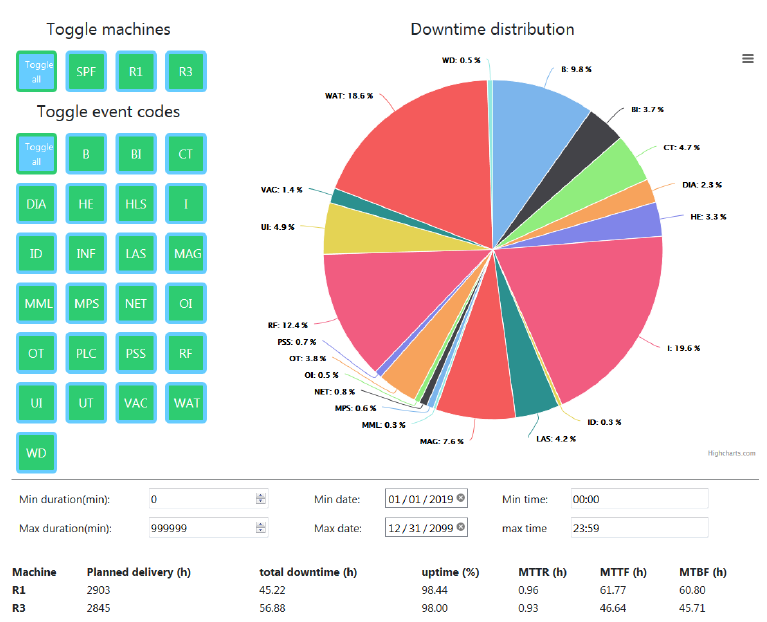
Figure 18. The front page of the downtime